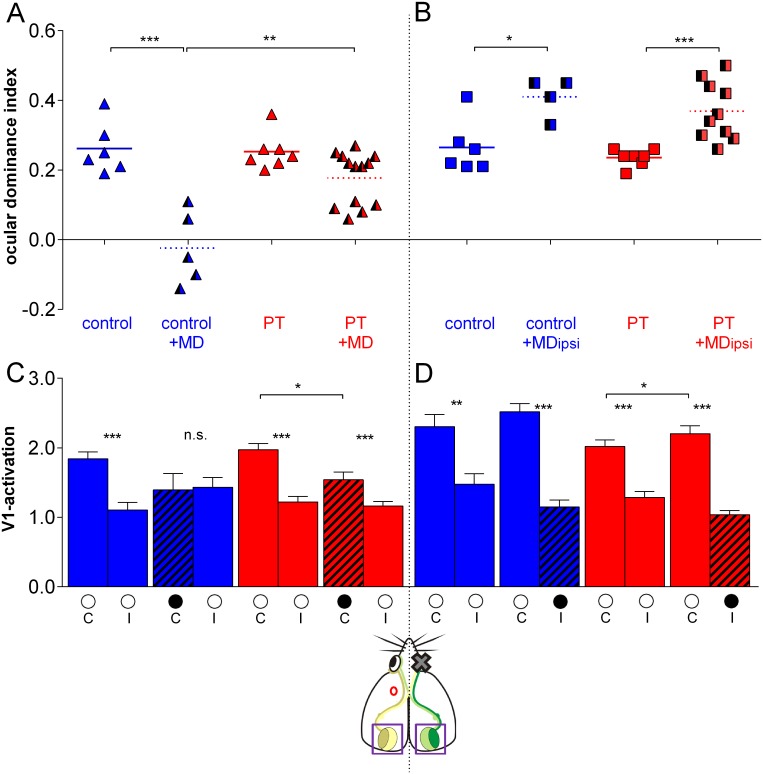
Quantification of the OD-indices and V1-activation.(A, B) Optically imaged OD-indices in sham-treated (control, blue) animals and after PT in M2 (red) without and with 7 days of MD of the right eye. Symbols represent ODI-values of individuals, means are marked by horizontal lines. (C, D) V1-activation elicited by stimulation of the contralateral (C) or ipsilateral (I) eye in control animals and after MD (black circle indicates MD eye). (A) In control mice, MD induced an OD-shift towards the open eye. In contrast, PT-mice did not show a significant OD-shift in the lesioned, left hemisphere. (B) In contrast, in the nonlesioned, right hemisphere, MD induced an OD-shift in PT-mice, as in control animals. (C, D) V1-activation after stimulation of the contra- and ipsilateral eye before and after MD in both control and PT-lesioned mice.